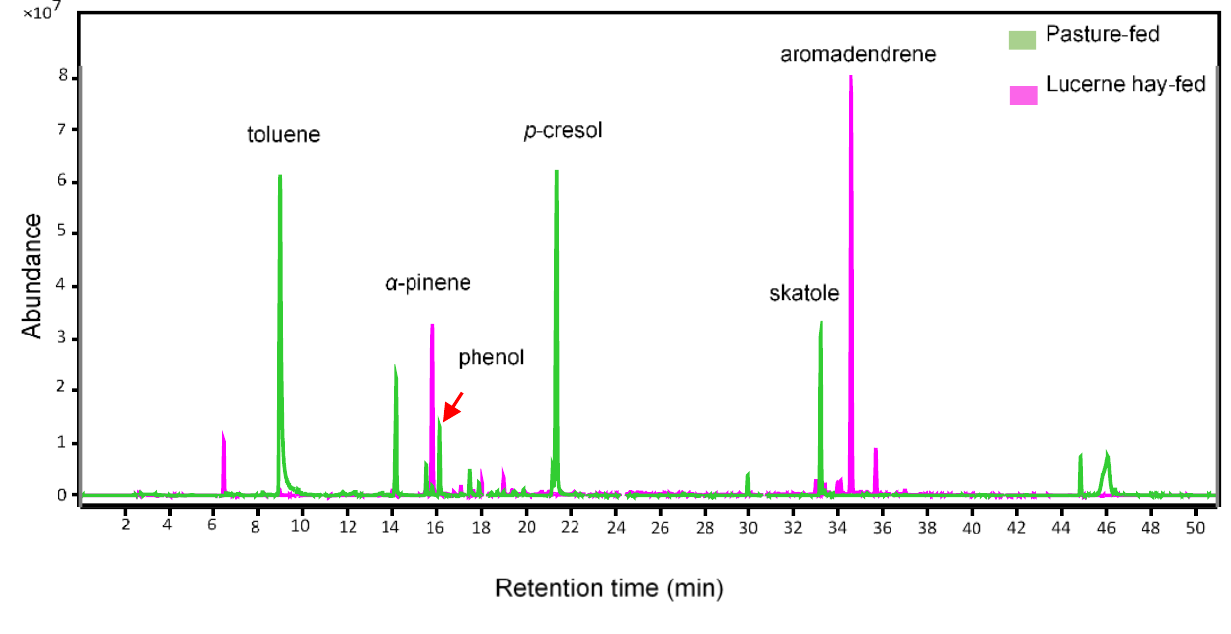
Figure 7. Representative gas chromatography/mass spectrometry total ion chromatograms of horse dung from animals fed on pasture and lucerne hay.